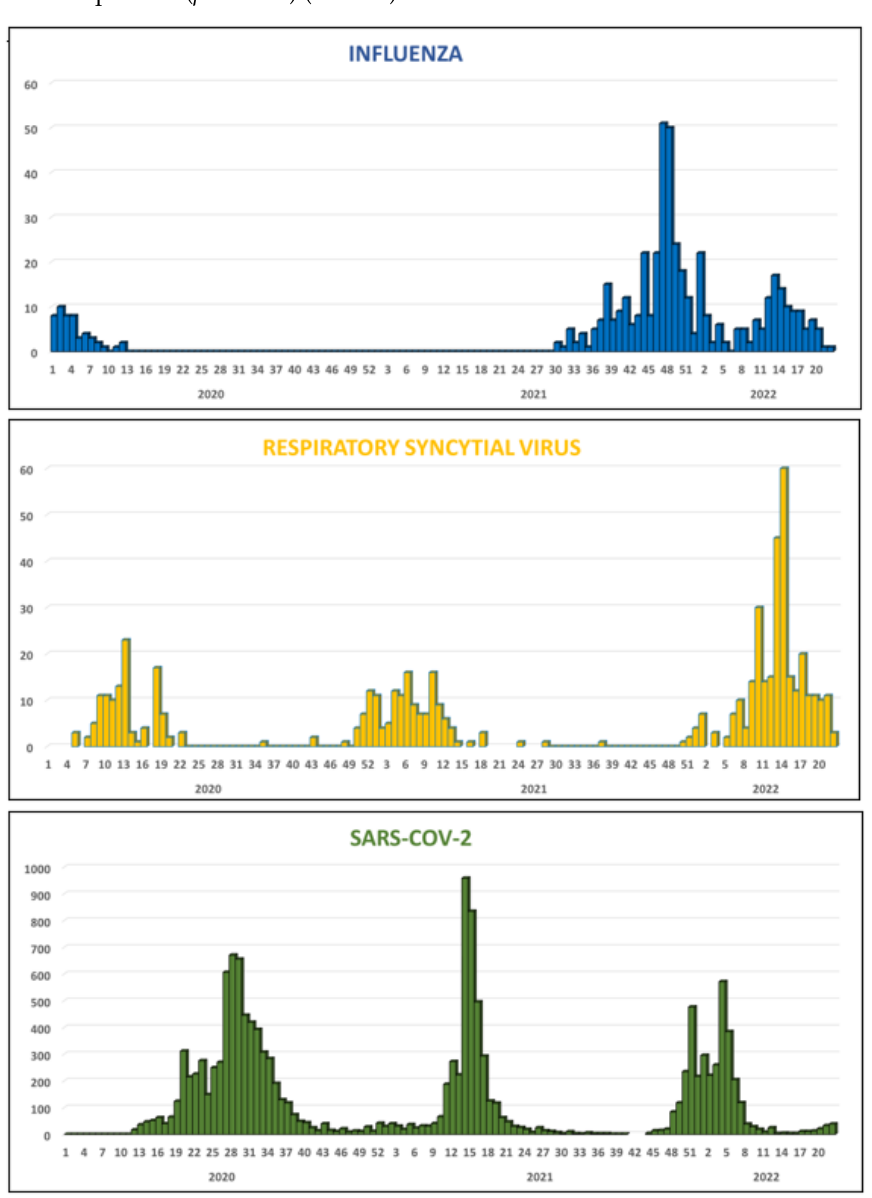
Figure 3. Weekly distribution of influenza, RSV, and SARS-CoV-2 detected by the Influenza Surveil- lance Network, January 2020 to May 2022,